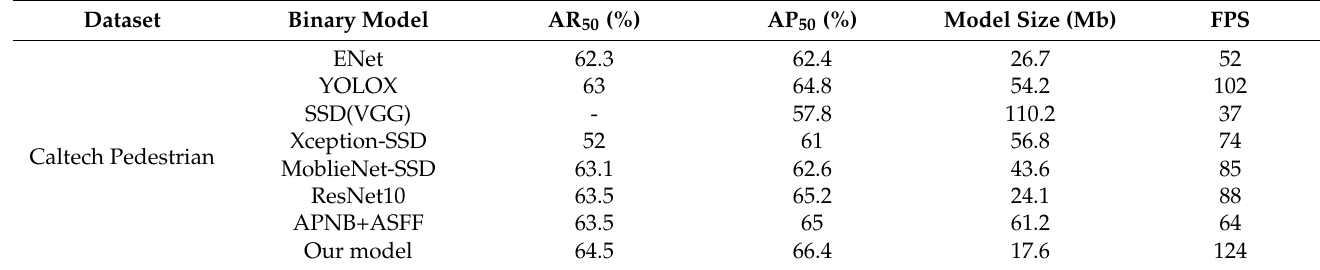
Table 6. Caltech Pedestrian dataset lightweight model comparison